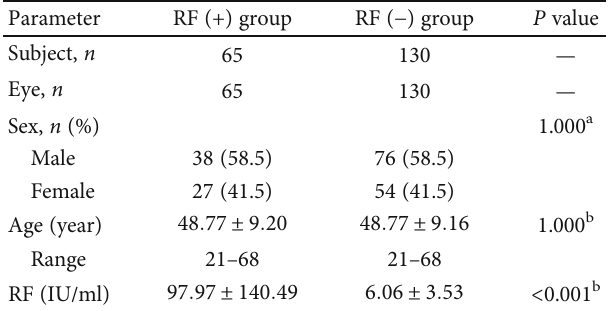
Table 3: The choroidal thickness by group.